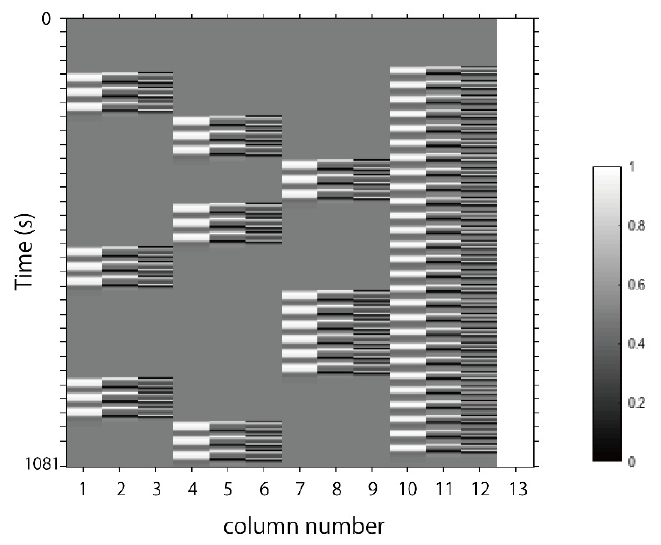
Figure 4. An example of design matrix X. The first peak delay was set as τ p = 6 s and “Time” indicates the row number of samples. The first to third columns indicate the canonical HRF f ( τ p , t ), the derivatives, and the second derivatives, respectively, for site 1. The fourth to sixth columns indicate the canonical HRF f ( τ p , t ), the derivatives, and the second derivatives, respectively, for site 2. The seventh to ninth columns indicate the canonical HRF f ( τ p , t ), the derivatives, and the second derivatives, respectively, for site 3. The tenth to twelfth columns indicate the canonical HRF f ( τ p , t ), the derivatives, and the second derivatives, respectively, for Rest. The thirteenth column indicates the constant.